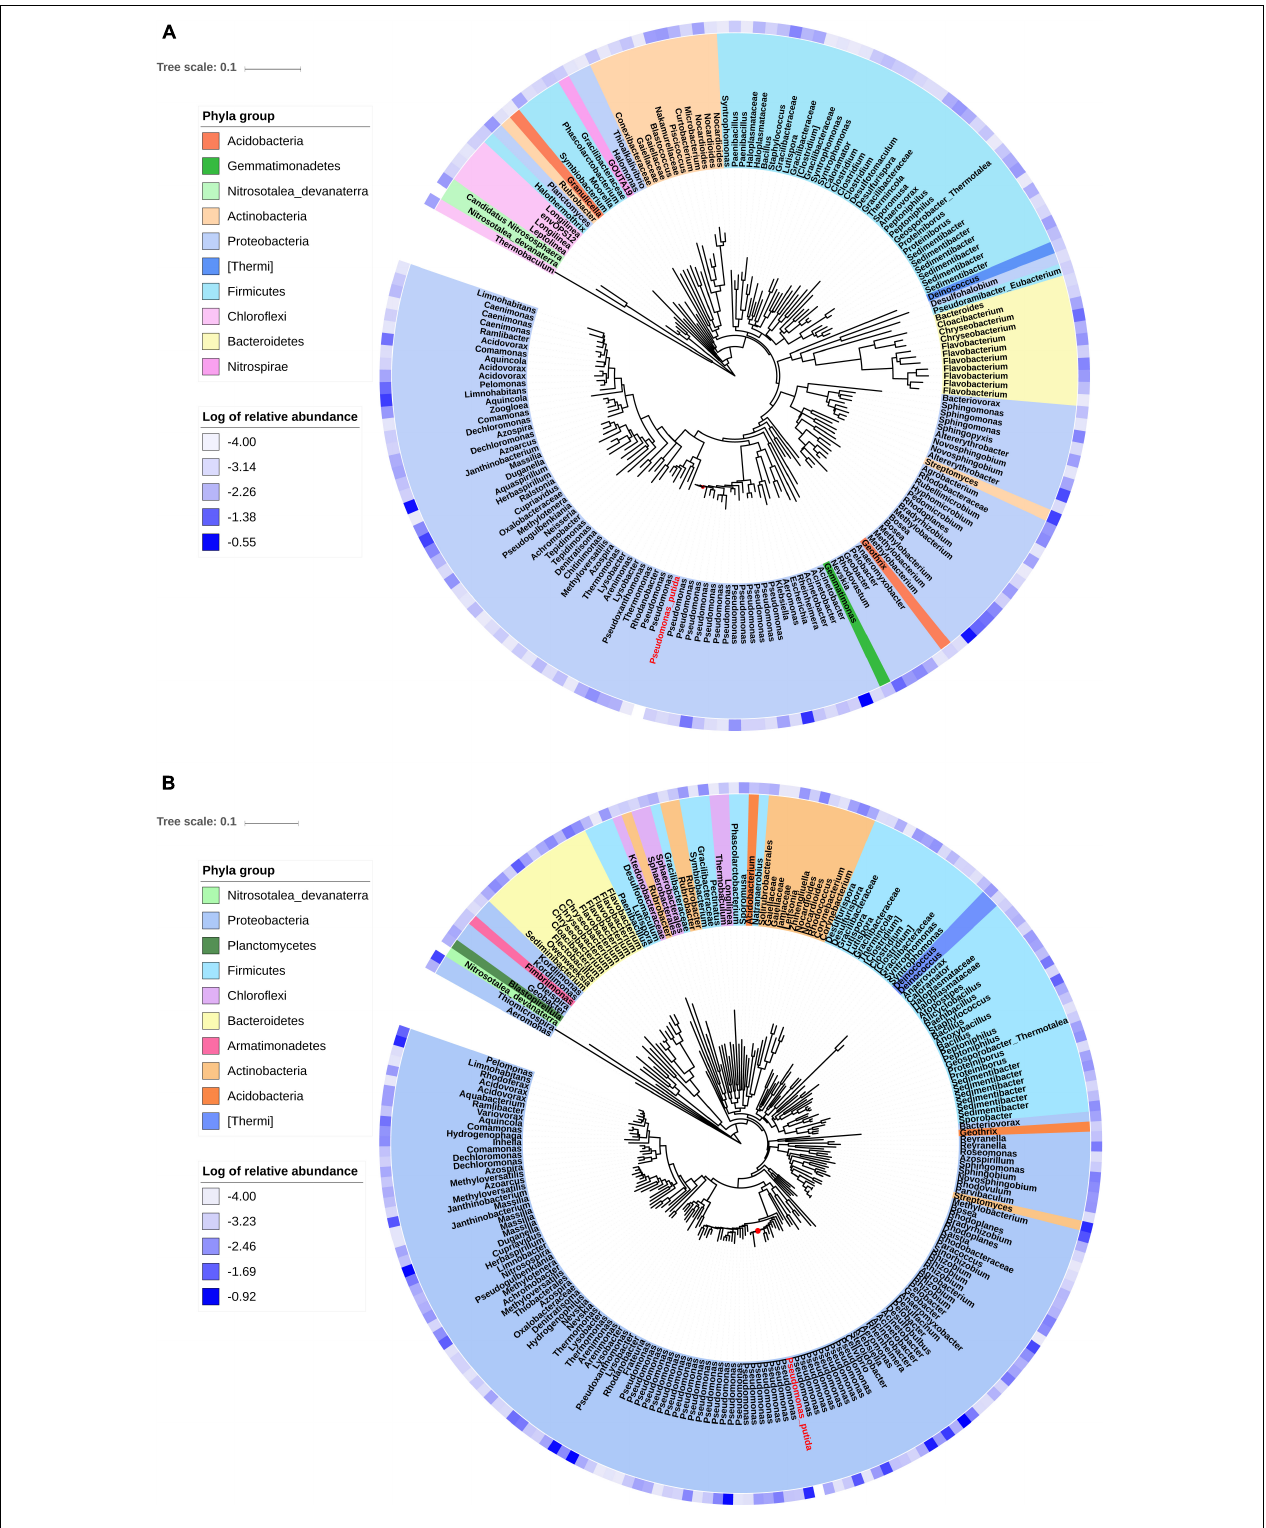
FIGURE 3 | Phylogenetic tree showing the identified OTUs that contributed more than 0.01% in the transconjugant pools. (A) Showing transconjugants on D5. (B) Showing transconjugants on D75. The 16S rRNA gene sequence of Pseudomonas putida (donor strain) was shown in red letters and Nitrosotalea devanaterra (distant relative species to most of the transconjugants) was imported as the reference. The blue gradient circle at the periphery of the tree represents log of relative abundance of the OTU in the transconjugant pools.